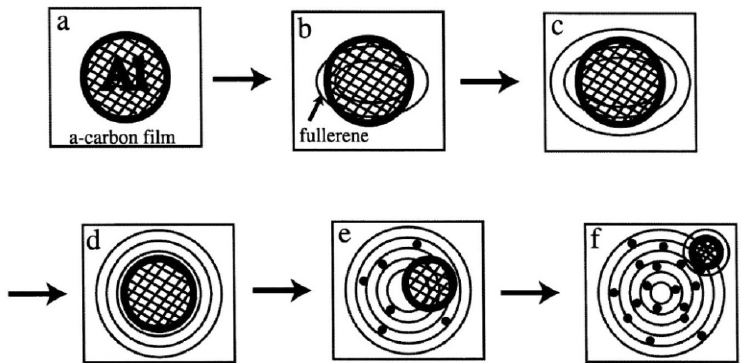
Figure 11. Series of reactions between Al nanoparticles and the amorphous carbon nanofilm (used as a specimen holder for TEM) induced by electron irradiation with an intensity of 10 20 e/cm 2 sec. Reactions proceed from the catalytic formation of ( a ) a graphitic shell and ( b ) an onion-like fullerene under the Al nanoparticle, followed by ( c ) shrinking of the nanoparticle and ( d ) intercalation of Al atoms inside the shell [10].